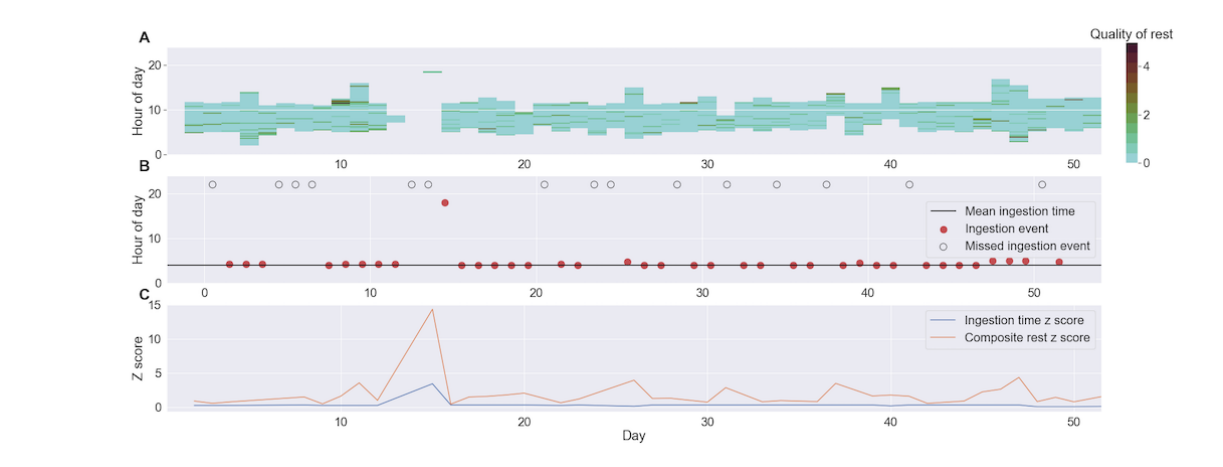
Figure 5. Daily relative rest quality and ingestion for a single patient. (A) The longest rest period for each day. Each bar represents the time windows that constitute the longest rest period for a given day. The color of each 15-minute interval within each bar represents the rest quality metric for that window. (B) Ingestion times for each day. Recorded ingestion events are marked with a red circle, missed ingestions are marked with an empty black circle, and the mean ingestion time across all days is represented by the horizontal line. (C) Ingestion and composite rest z scores. The composite rest z score (in orange), which is the sum of the rest quality, starting time, and duration z score, and the ingestion time z score (in blue) are plotted across all days for the same patient. We searched for data points where outliers in the composite rest z score occurred near the same day as a corresponding outlier in the ingestion time z score (eg, on day 15). Note that days without recorded patch data were excluded from the analysis.